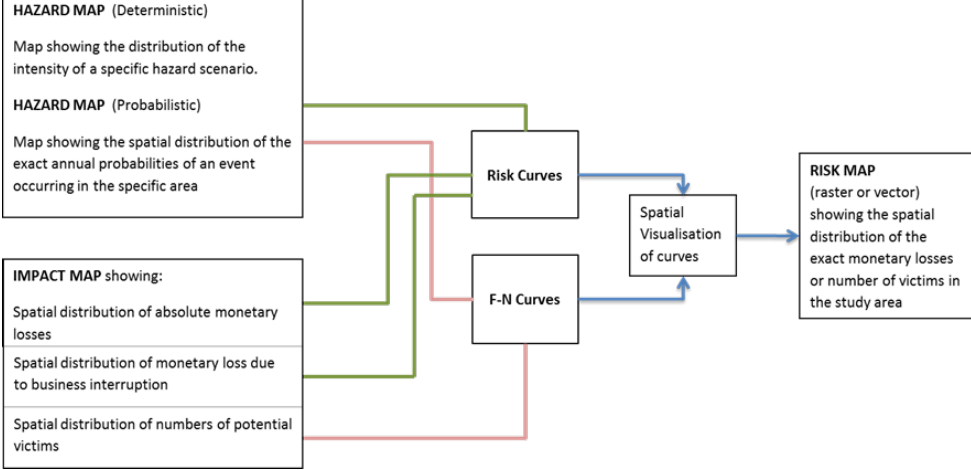
Figure 7. The quantitative risk analysis and mapping procedure [46].